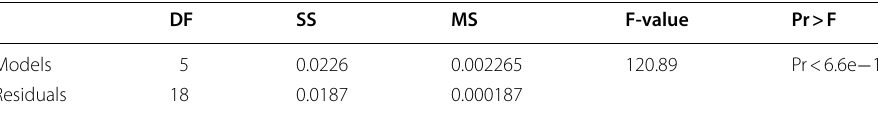
Table 5 ANOVA initial